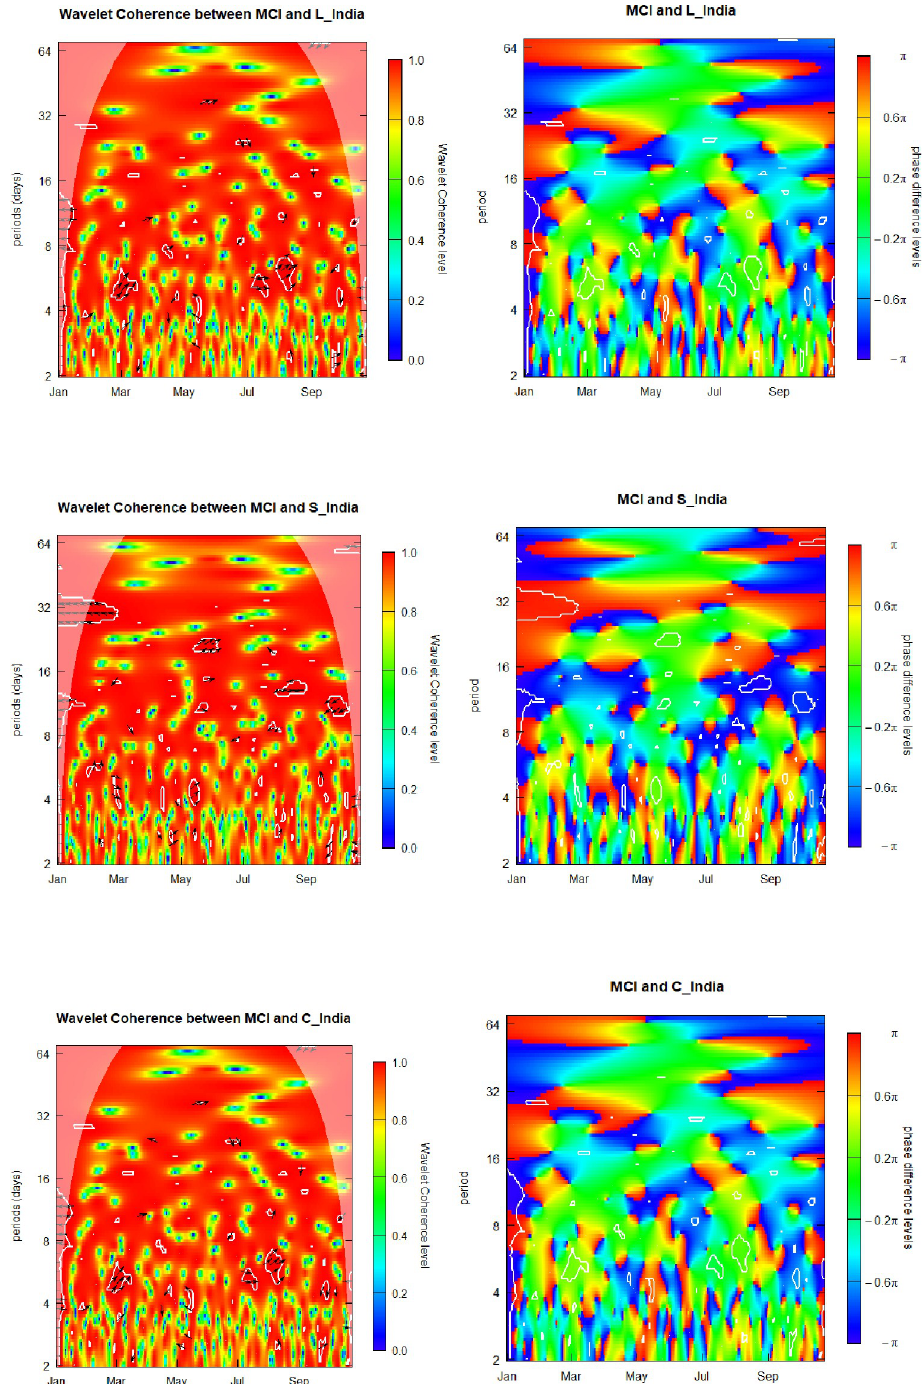
Fig 3. Media Coverage Index (MCI) and sovereign yield components of India. L_India, S_India, and C_India denote the level, curvature and slope component for India.